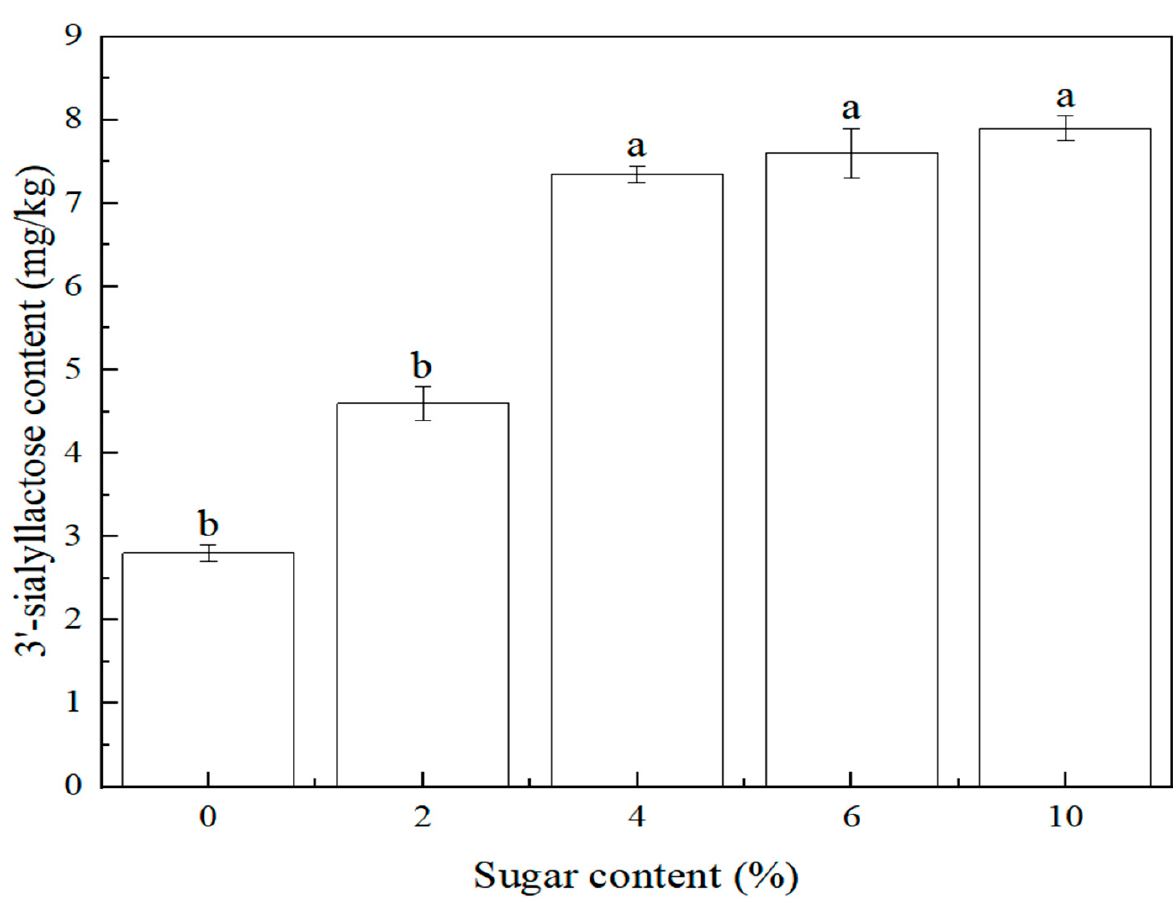
Table 4 . Comparison of 3’-sialyllactose content in different edible bird’s nest products ( n = 2, p < 0.05). NO. Type Batch Number